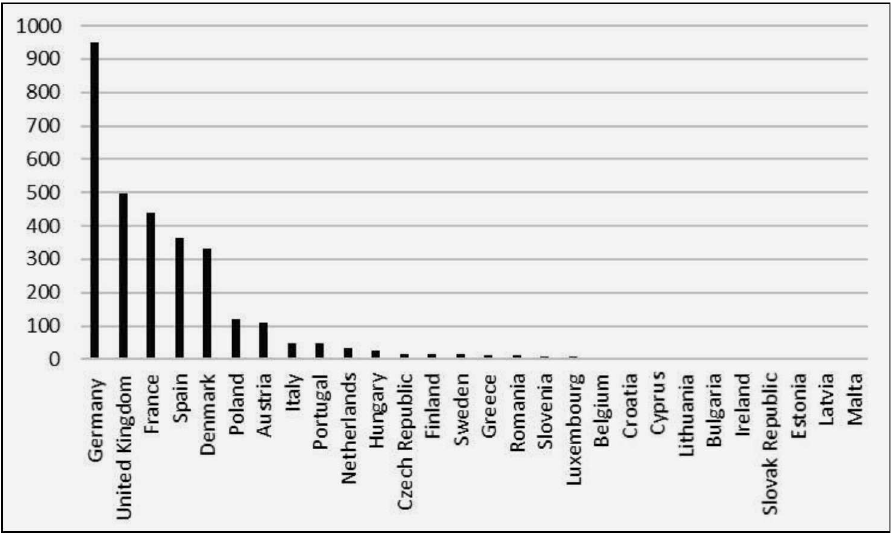
Source: own elaboration based on FCHO,